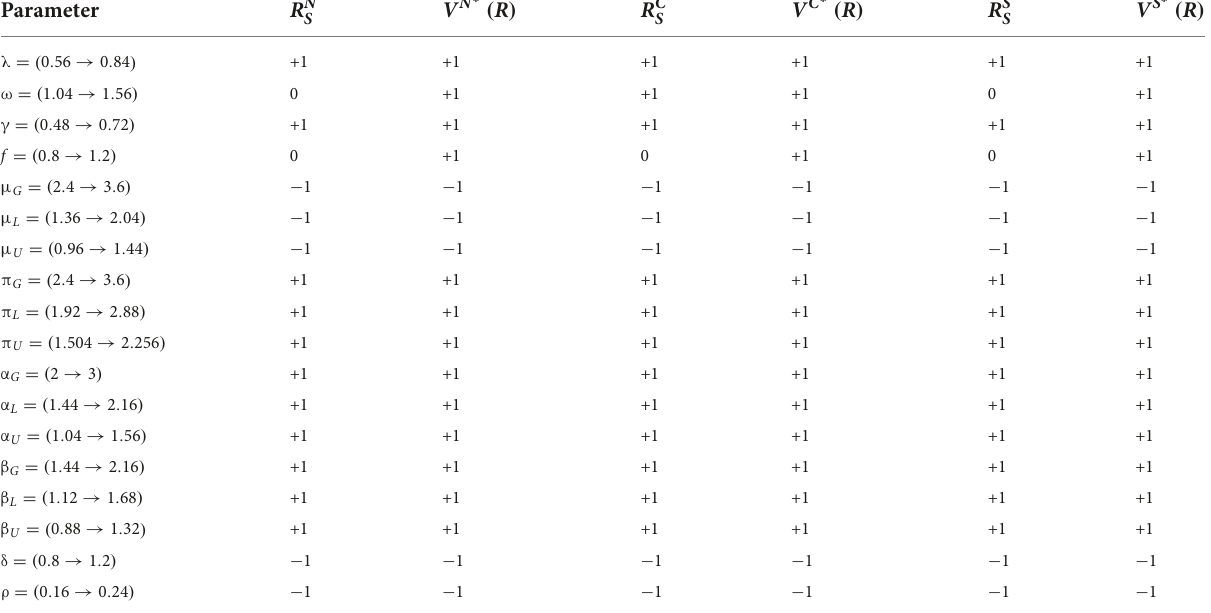
TABLE 5 Sensitivity analysis of each parameter in the model.